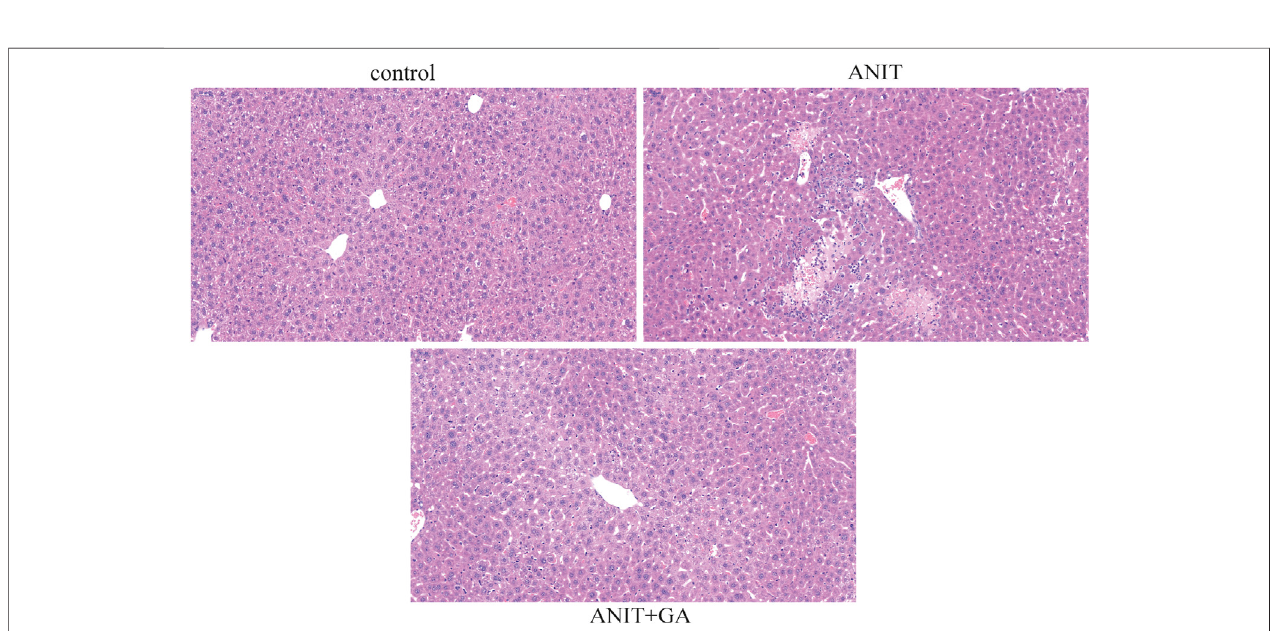
FIGURE 2 | Effects of GA on histological changes in ANIT-induced cholestasis mice (HE stain, × 20).